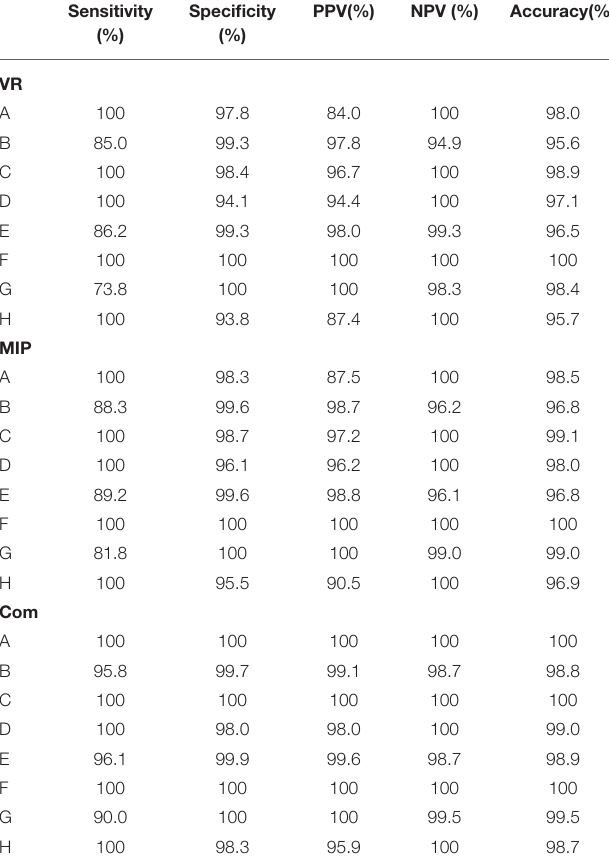
TABLE 2 | Specificity, sensitivity, PPV, NPV, and accuracy between VR, MIP, the original images and the combined analysis of the various types the circle of Willis. Sensitivity